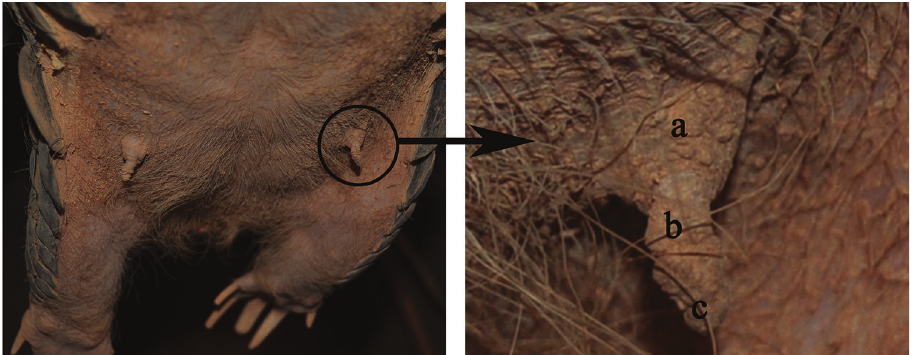
Figure 1. Breast and waxy secretion covering the nipple surface of the female pangolin MP8 for the parturition the day before (by Fuhua Zhang, 18 Oct 2011). a breast b nipple c waxy secretion covering the nipple surface.